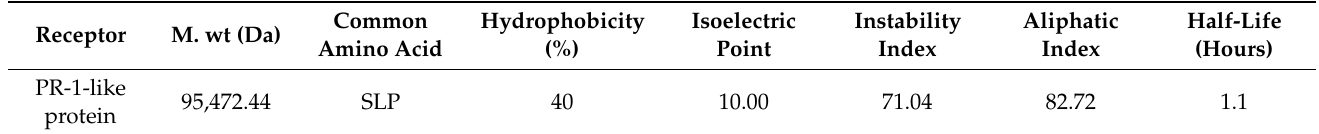
Table 5. Physicochemical of the PR-1-like protein, Fpr1, of Fusarium oxysporum . Receptor M. wt (Da)